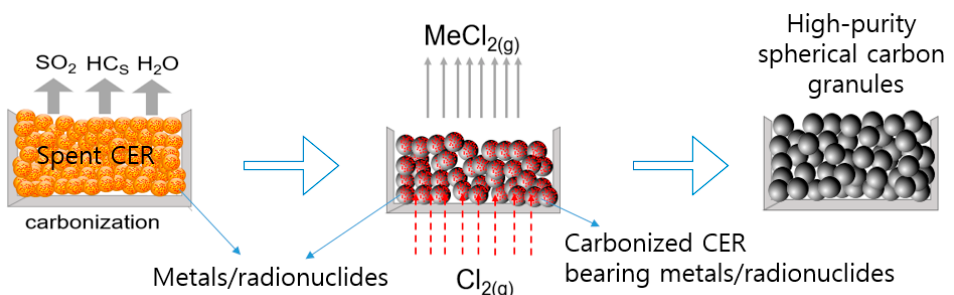
Figure 2. Principle of the carbonization and halogenation treatment process for the removal of radionuclides from spent ion-exchange resins.